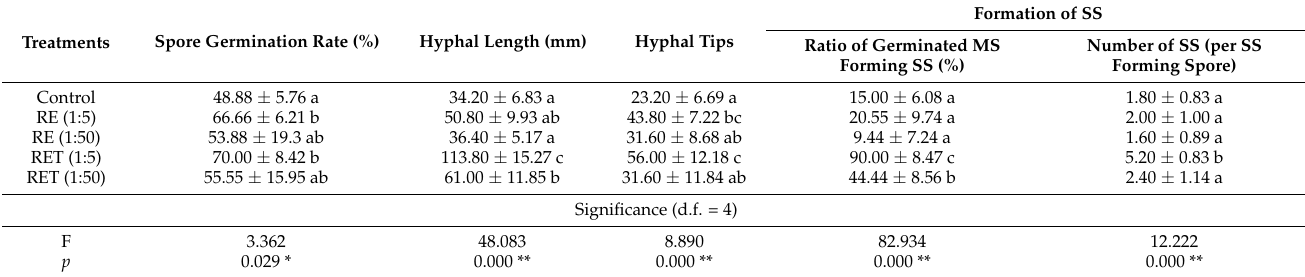
Table 1. Effects of root exudates or extracts on Funneliformis mosseae spore germination and hyphal differentiation.